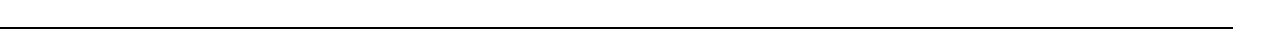
Fig. 6 P2rX7 activation rescues impaired Tet DKO BMMSCs and osteopenia phenotype in Tet DKO mice. a The levels of miR-297a-5p, miR-297b-5p, and miR-297c-5p in control, Tet DKO BMMSCs, and P2rX7 CRISPR activation plasmid-treated Tet DKO BMMSCs. b Bradford assay showed the exosome secretion in control, Tet DKO BMMSCs, and P2rX7 CRISPR activation plasmid-treated Tet DKO BMMSCs. c Western blotting showed the expression of CD9 and CD81 in control, Tet DKO BMMSCs, and P2rX7 CRISPR activation plasmid-treated Tet DKO BMMSCs. d , e Mineralized nodule formation and the expression of Runx2 , ALP, and OCN in control, Tet DKO BMMSCs, and P2rX7 CRISPR activation plasmid-treated Tet DKO BMMSCs, as assessed by alizarin red staining ( d ) and western blotting ( e ). f The expression of miR-297a-5p, miR-297b-5p, and miR-297c-5p in control, Tet DKO BMMSCs, and adeno- associated P2rX7 overexpression virus ( P2rX7 AAV)-treated Tet DKO BMMSCs, as assessed by qPCR. g Bradford assay showed the exosome secretion level in control, Tet DKO BMMSCs, and P2rX7 AAV-treated BMMSCs. h Western blotting showed the expression of CD9 and CD81 in exosomes derived from control, Tet DKO BMMSCs, and P2rX7 AAV-treated BMMSCs. i Bone mineral density (BMD) of trabecular bone (TB) area in distal femurs of control, Tet DKO, and P2rX7 AAV-treated-mice, as assessed by micro-CT. j The cortical bone area (Ct.Ar) and cortical thickness (Ct.Th) of the femurs of control, Tet DKO, and P2rX7 AAV-treated-mice analyzed by micro-CT. k , l H&E staining showed the TB volume (yellow-circled area) of control, Tet DKO, and P2rX7 AAV-treated-mice. m The capacity of BMMSCs isolated from control, Tet DKO, and P2rX7 AAV-treated-mice to form mineralized nodules as assessed by alizarin red staining. n Western blotting analysis showed the expression levels of the osteogenic markers Runx2 , ALP , and OCN in control, Tet DKO, and P2rX7 AAV-treated Tet DKO BMMSCs. The 8 – 10-week-old Tet1 − / − Prx1 cre Tet2 fl / fl mice were used as Tet DKO mice in our experiments, and their littermates whose genetic status was Prx1 cre were used as controls. * p < 0.05, ** p < 0.01, *** p < 0.001 (mean ± SD). Scale bars, 400 μ m ( i , j ), 1 mm ( k ). Results are from three independent experiments. p values were calculated using one-way